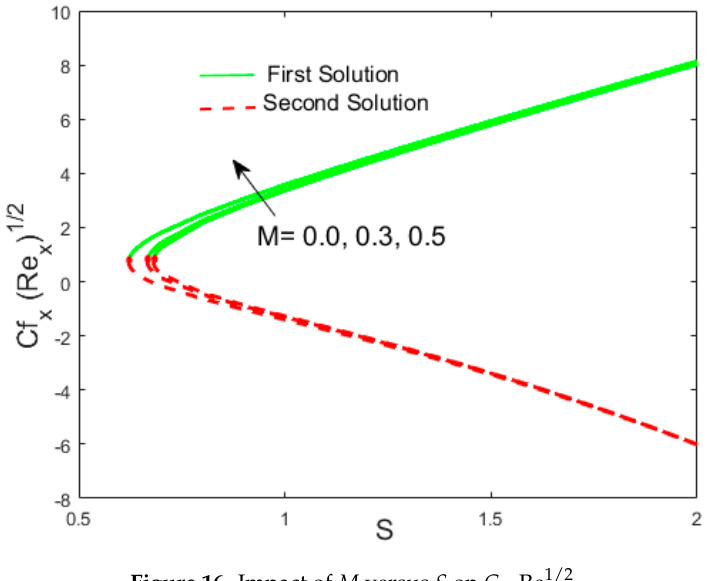
Figure 16. Impact of M versus S on C fx Re 1/2 x .